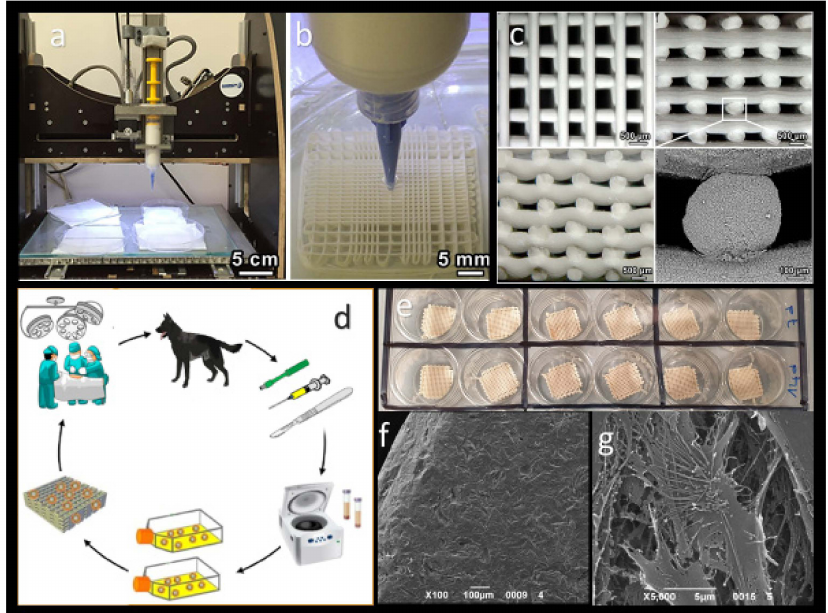
Figure 3. ( a ) Three-dimensional printing of silicone-based scaffold using DIW; ( b ) detail of 3D- printing process in an oil bath; ( c ) morphology of ceramic 3D-printed scaffolds from different views and high magnification detail of a rod fracture surface; ( d ) MSCs therapy steps include retrieval of adipose tissue from healthy dogs, isolation and characterization of cAD-MSCs, pelleting and seeding the cAD-MS on scaffolds, and its potential in vivo or in clinical applications; ( e ) cAD-MSCs pelleted and seeded onto the carbon-based scaffolds. SEM images of cAD-MSCs 7 days after culture on carbon- based scaffolds at magnifications of ( f ) 100 × and ( g ) 5000 × reveal significant secretome activity of the cell surfaces on the carbon-based scaffolds. ( a – c ) copyright 2022, IOP Publishing; ( e – g )